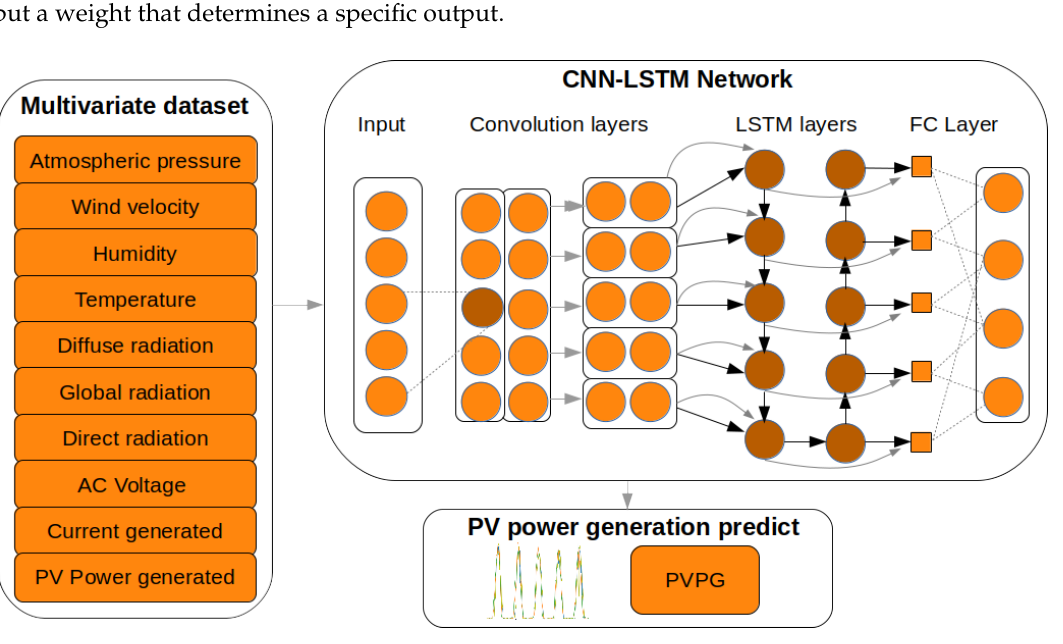
Figure 8. The CNN-LSTM general